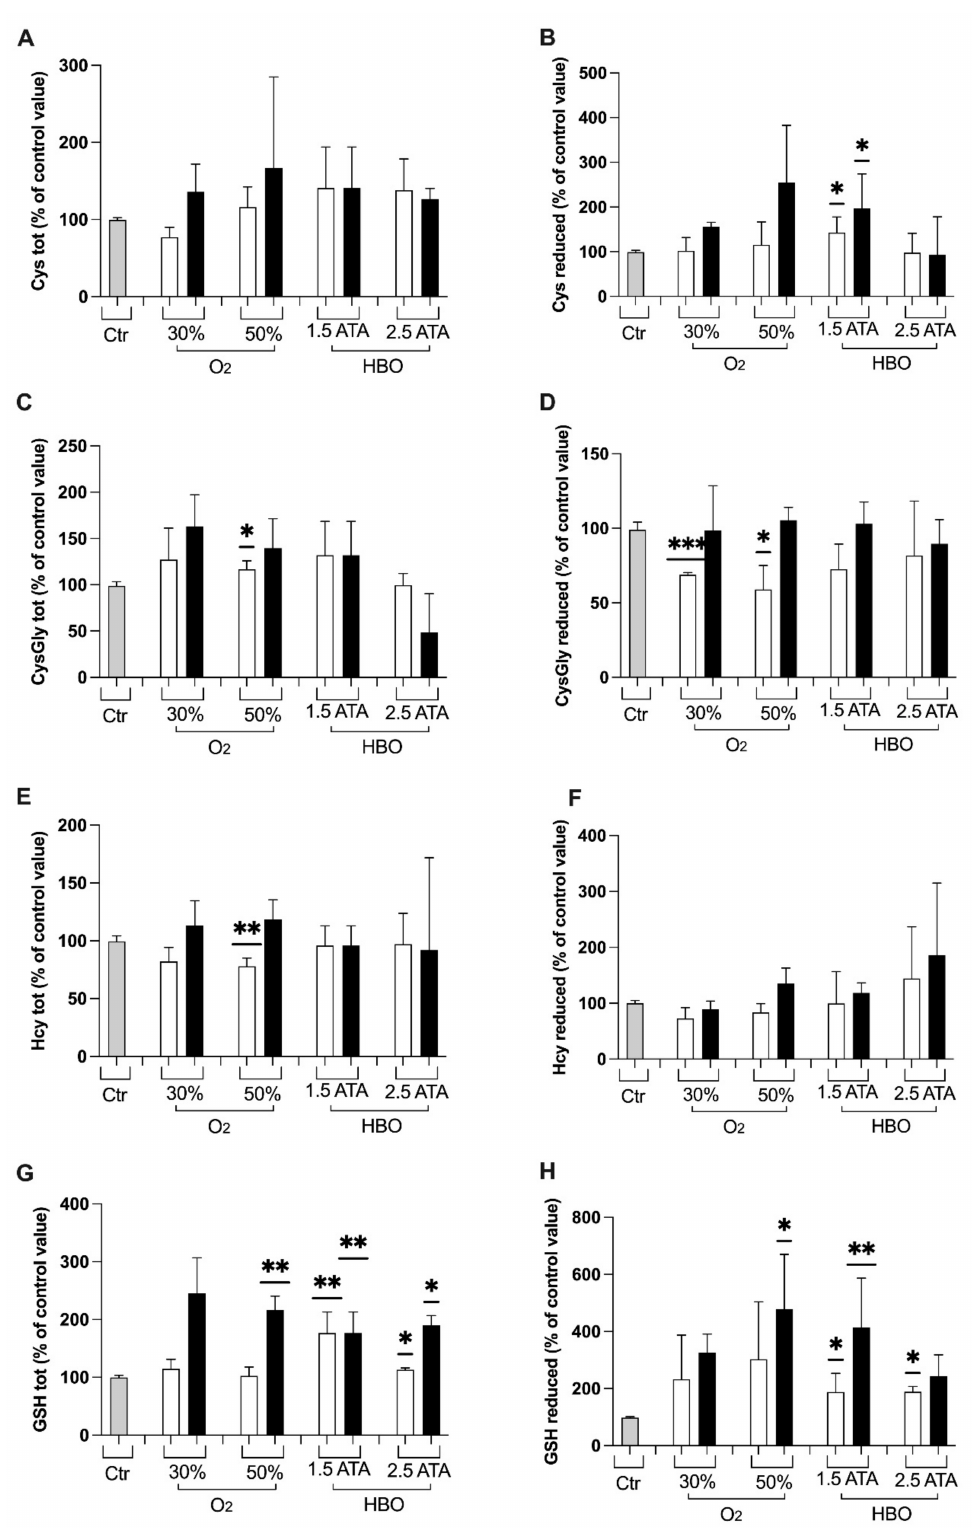
Figure 4. Histogram plot (% ± SD) of total and reduced aminothiols. The control group (Ctr) is reported in grey; white and black bars identify T1 and T2, respectively. Significant difference intra-group: * p < 0.05; ** p < 0.01; *** p <